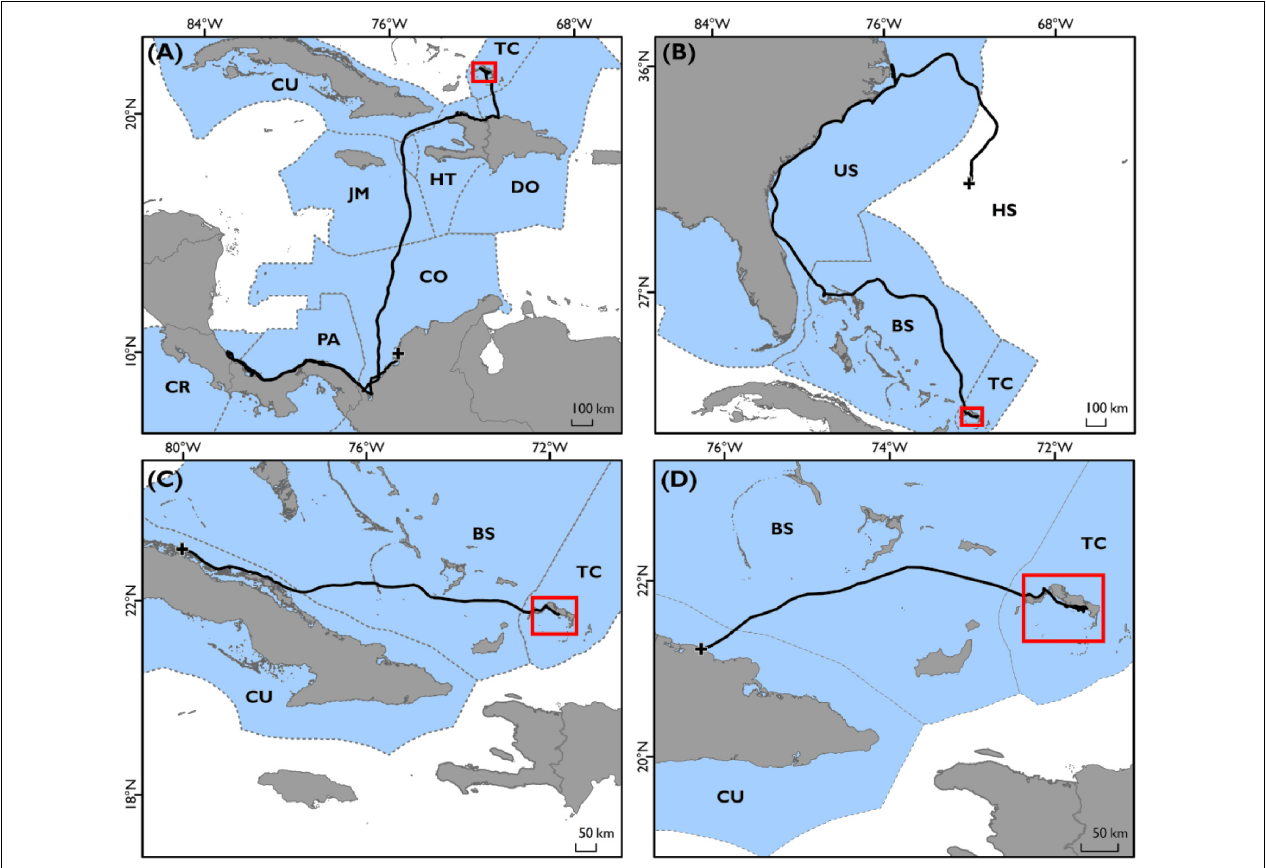
FIGURE 2 | Geo-political zones (blue polygons) occupied by turtles that exhibited wide-ranging movements away from the Turks and Caicos Islands Economic Exclusive Zone (EEZ; n = 4). Each panel shows full track of an individual turtle (black dots); (A) Turtle G, (B) Turtle A, (C) Turtle M, and (D) Turtle B. Two-letter international country codes for each EEZ shown; TC; Turks and Caicos Islands, CU; Cuba, HT; Haiti, DO; Dominican Republic, JM; Jamaica, CO; Colombia, PA; Panama, CR; Costa Rica, BS; The Bahamas, US; United States of America, and HS; High Seas. All tracks originate from Turks and Caicos Islands (red boxes) and end location denoted by black